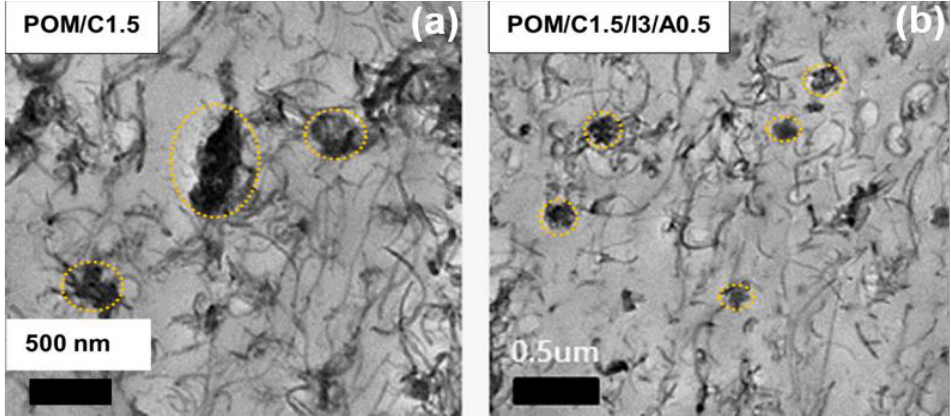
Figure 15. TEM images of ( a ) POM/C1.5, and ( b ) POM/C1.5/I3/A0.5 nanocomposites.